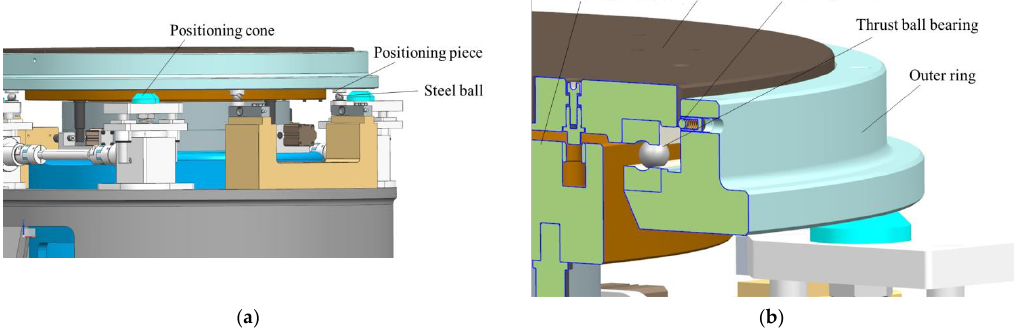
Figure 14. ( a ) The schematic of mass centroid measurement state; ( b ) The detail view of mass centroid measure state. ⚫ The MOI measurement state